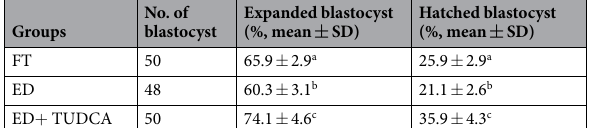
Table 2. Effect of TUDCA supplementation during embryo culture on the production of expanded and hatched blastocyst. Note: Different letters within the same column indicate statistical differences at p < 0.05 by one-way ANOVA followed by the LSD multiple comparison test (N = 5). FT: blastocysts developed from conventional freeze-thaw boar spermatozoa without TUDCA-treatment; ED and ED + TUDCA: blastocysts developed from evaporatively dried boar spermatozoa with 0 and 200 μ M TUDCA-treatment, respectively.